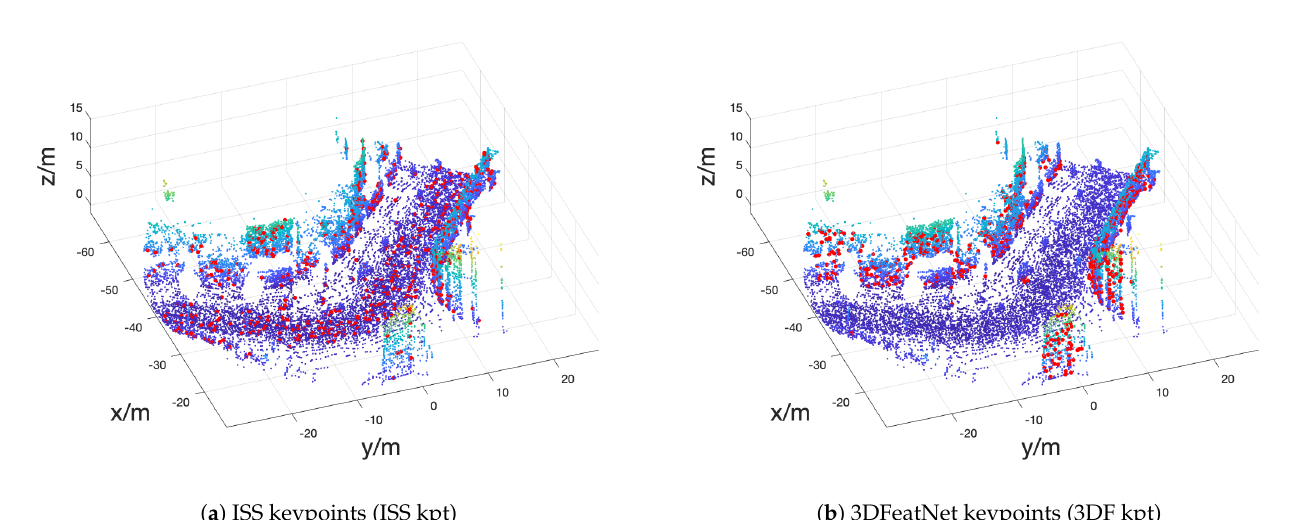
Figure 1. Keypoints demo. Two different keypoint detectors are applied to one selected Oxford frame, respectively: (left) ISS detector; and (right) 3DFeatNet Detector. Keypoints are plotted with red dots on point cloud.